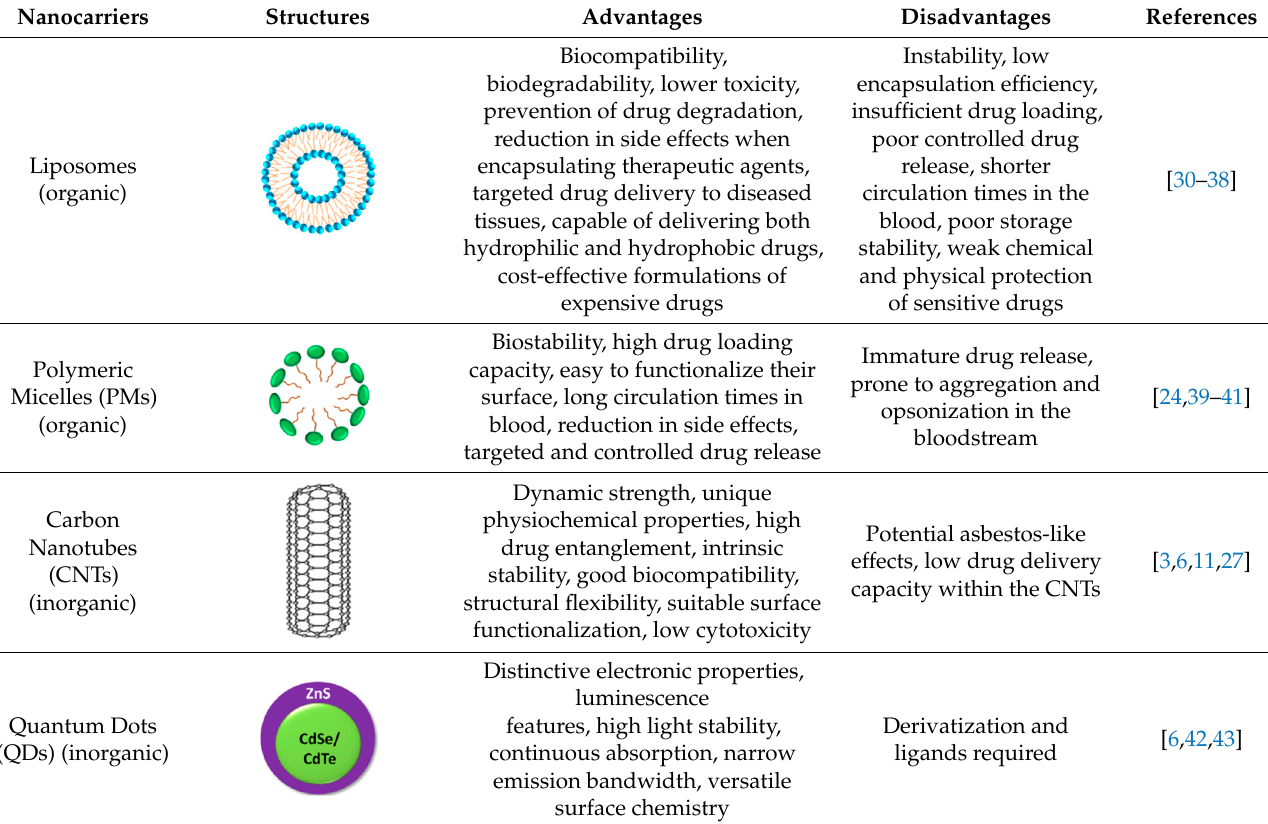
Table 1. Nanocarriers for targeted drug delivery.